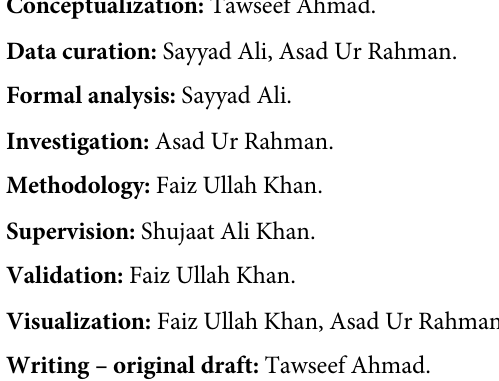
S1 Table. Strength and dose of dispensed antibiotics for the predesigned clinical scenarios (URTI and UTI). Community pharmacist and dispenser dispensed different dose and strength of antibiotics, the most and least both are shown in Table